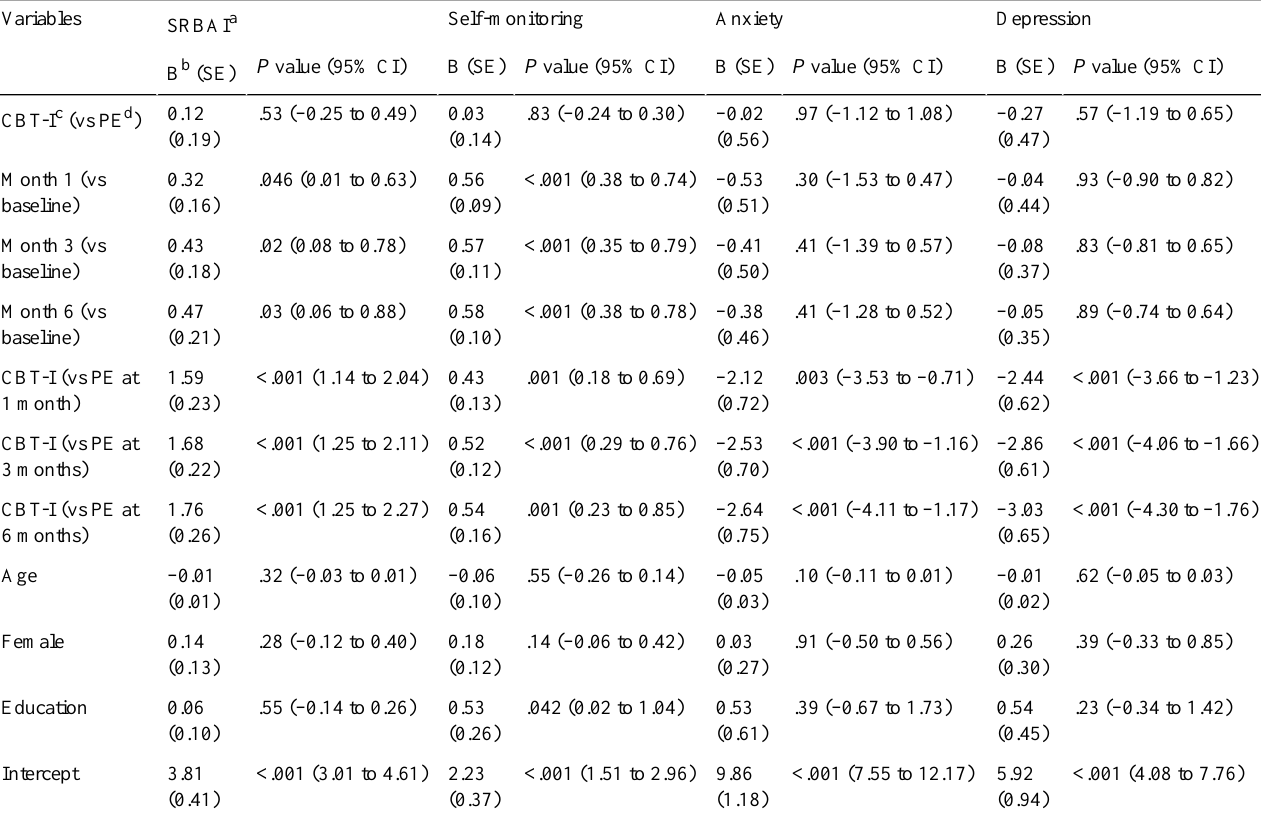
Table 6. Results of the linear mixed models for measures on control theory concept and psychological distress (anxiety and depression). DepressionAnxietySelf-monitoringSRBAI a